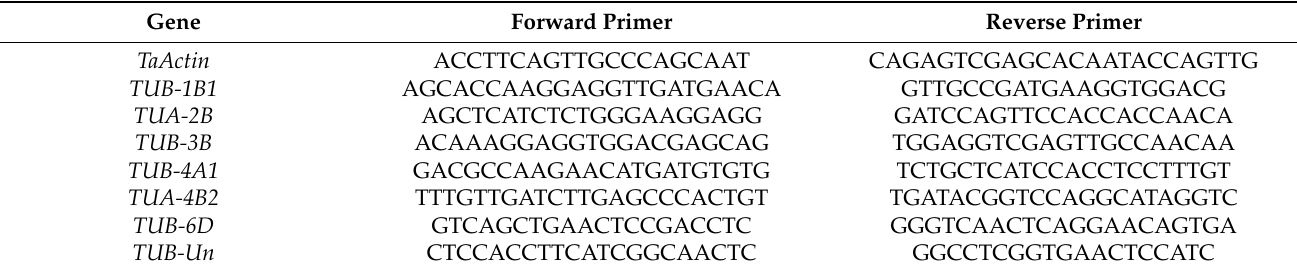
Table 3. Primers in this